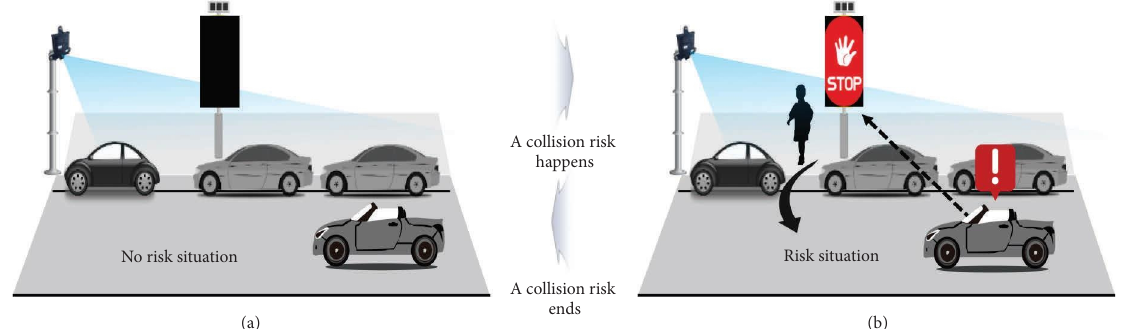
Figure 7: LED-VMS provides warning information about collision risks. (a) In a normal situation, LED-VMS is of. (b) In a risk situation, LED-VMS is turned on until the risk situation is over.